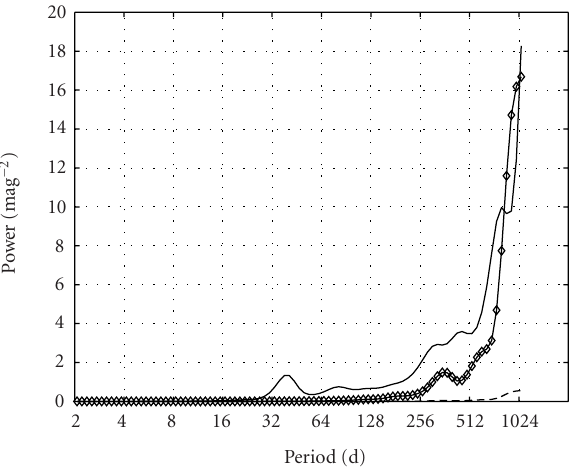
Figure 13: Global wavelet spectrum of the AC Herculis signal (solid line) compared to the GWS from the corresponding sampling signal (dashed line).